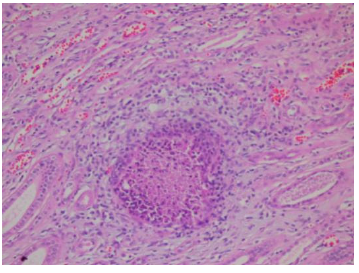
FIGURE 3. Caseating granulomatous renal tuberculosis. Epithelioid cells surround a central area of necrosis that appears irregular, amorphous, and pink. Hematoxylin-eosin stain, original magnification ×